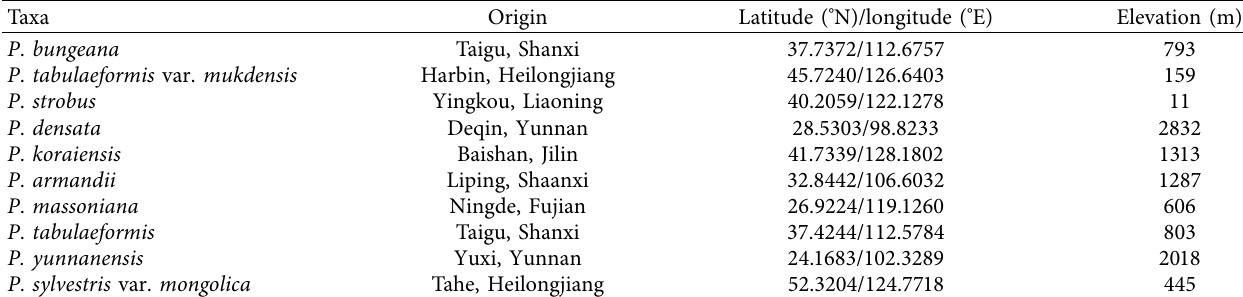
Table 1: The origins and geographical characteristics of the ten Pinus